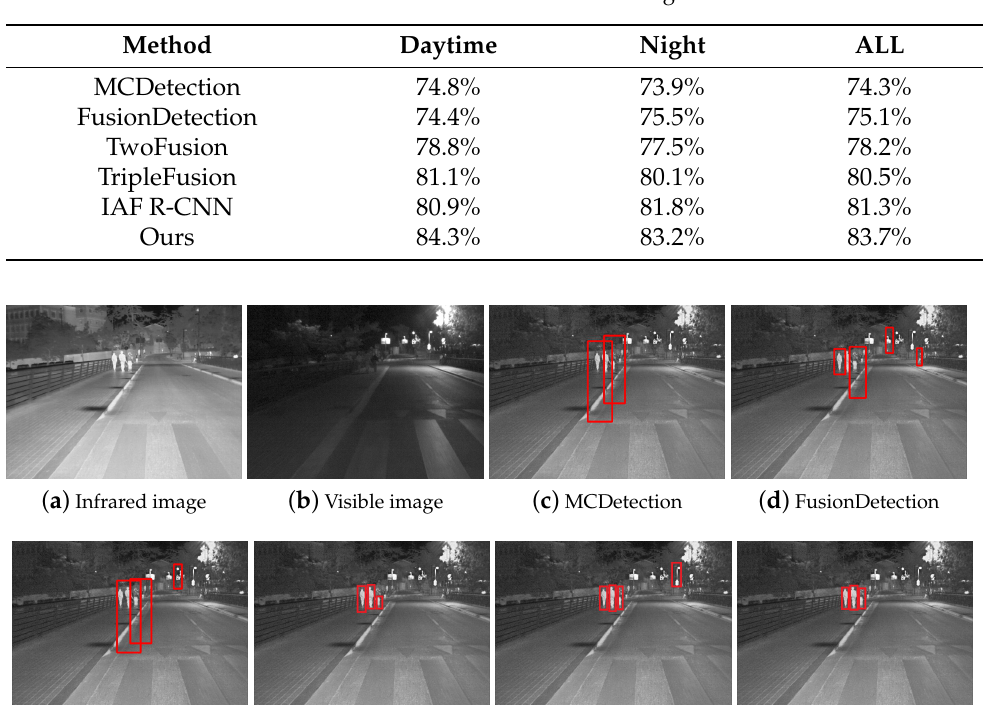
Table 2. The mAP for the different detection methods on the testing set.